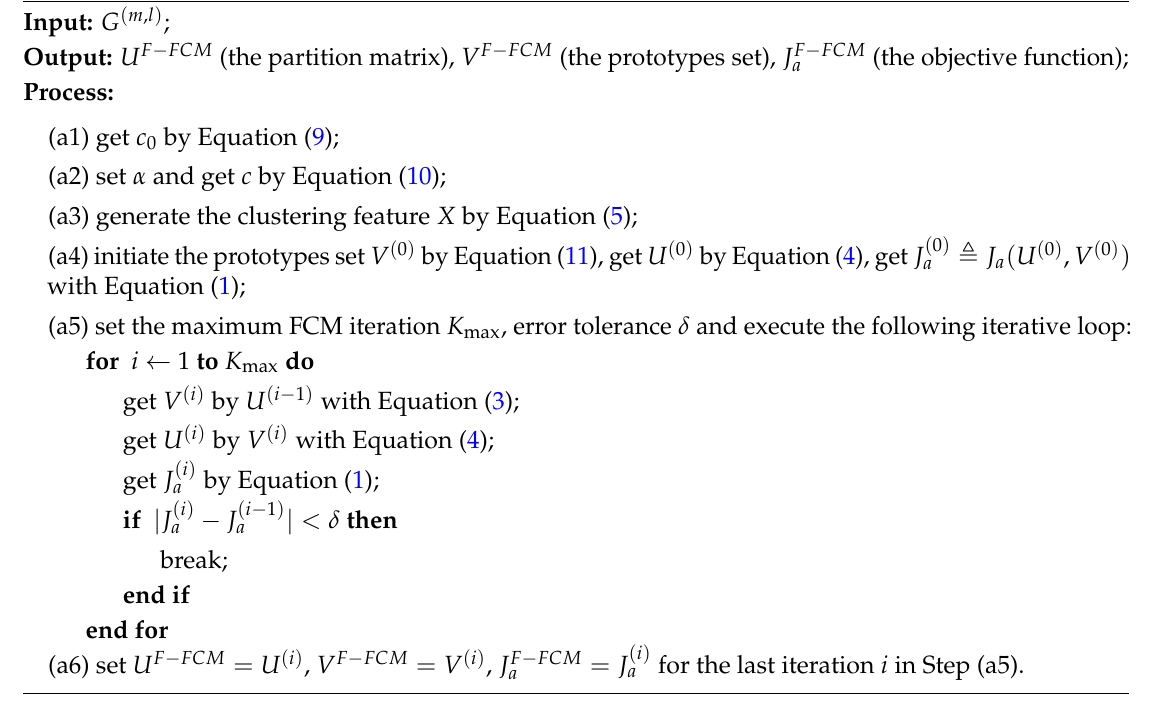
Algorithm 1 F-FCM clustering algorithm.